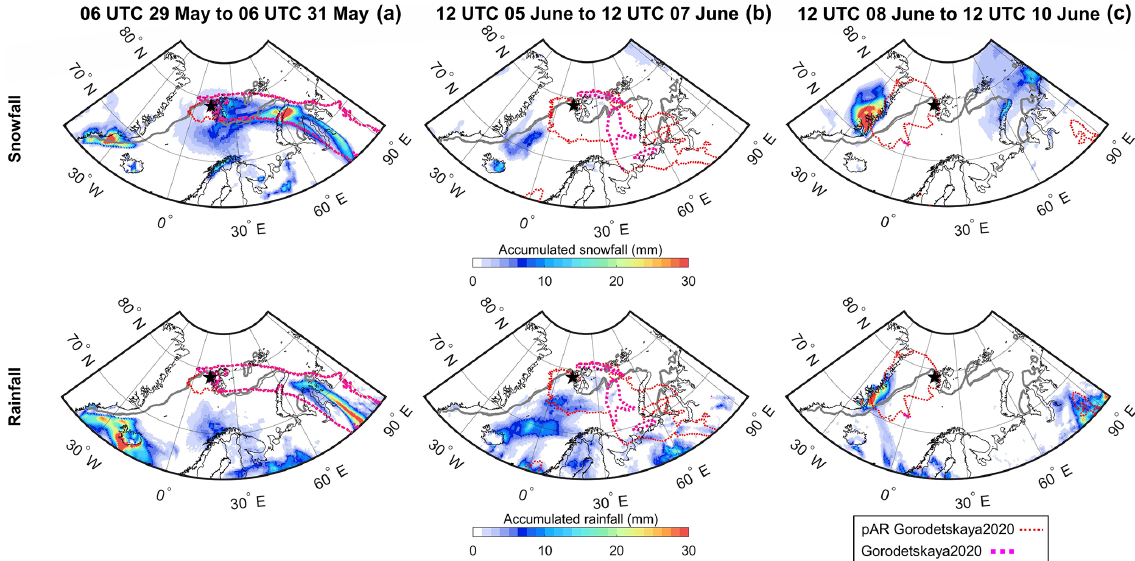
Figure 9. Maps of the accumulated snowfall (mm, coloured shading, top row) and rainfall (mm, coloured shading, bottom row) for the 30 May event (a) , the 6 June event (b) , and the 9 June event (c) during a 48h period (24h before and after the AR reaches Ny-Ålesund, shown by the black star) based on ERA5 reanalysis. The grey lines show the sea-ice fraction using a 15% threshold (the thin line represents 24h before the event, and the thick line represents 24h after the event). The magenta and red lines show the respective AR and pAR shapes based on Gorodetskaya2020. Here, the AR shape lines encompass the total area of the ARs/pARs during the 48h period. Figures S11, S12, and S13 show the discrimination of the precipitation phase (snowfall and rainfall) for all